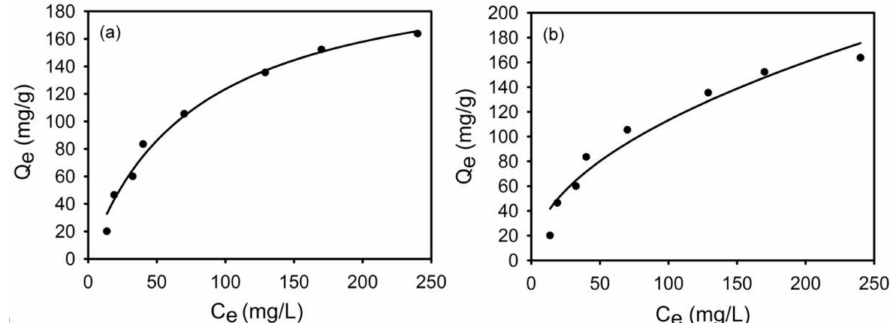
Figure 14. ( a ) Langmuir plot and ( b ) Freundlich plot for the adsorption of Pb(II) by g-PAM/OVerm